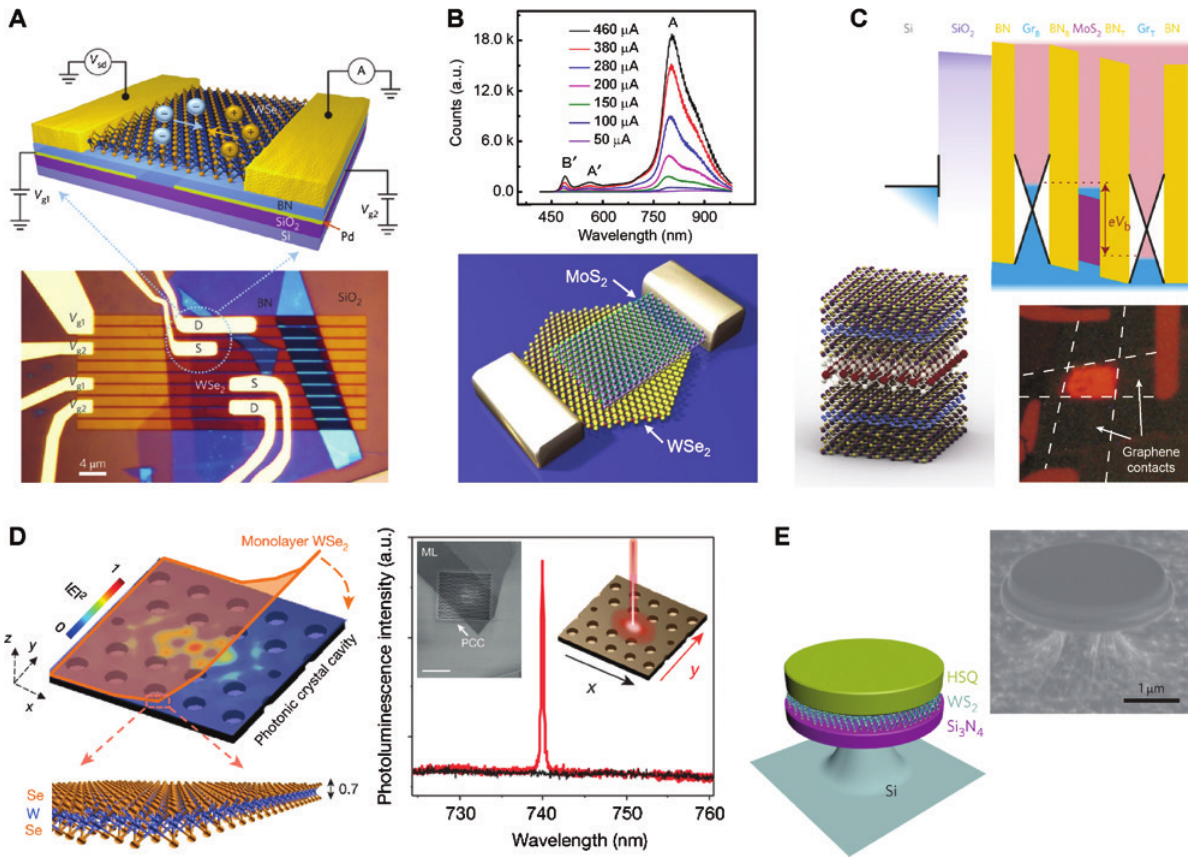
LED, which uses a split back gate configuration to electrostatically induce a p-n junction in the channel. Figure 5: (A) A monolayer WSe 2 Using BN as a gate dielectric helped to improve the quantum efficiency of the device. (B) A van der Waals p-n junction using an n-MoS /p-WSe heterostructure. The lowest-energy exciton dominates the electroluminescence spectrum. (C) A van der Waals tunneling 2 2 LED. Graphene/BN tunneling contacts are used to inject holes and electrons into the monolayer TMDC active layer. Quantum efficiencies